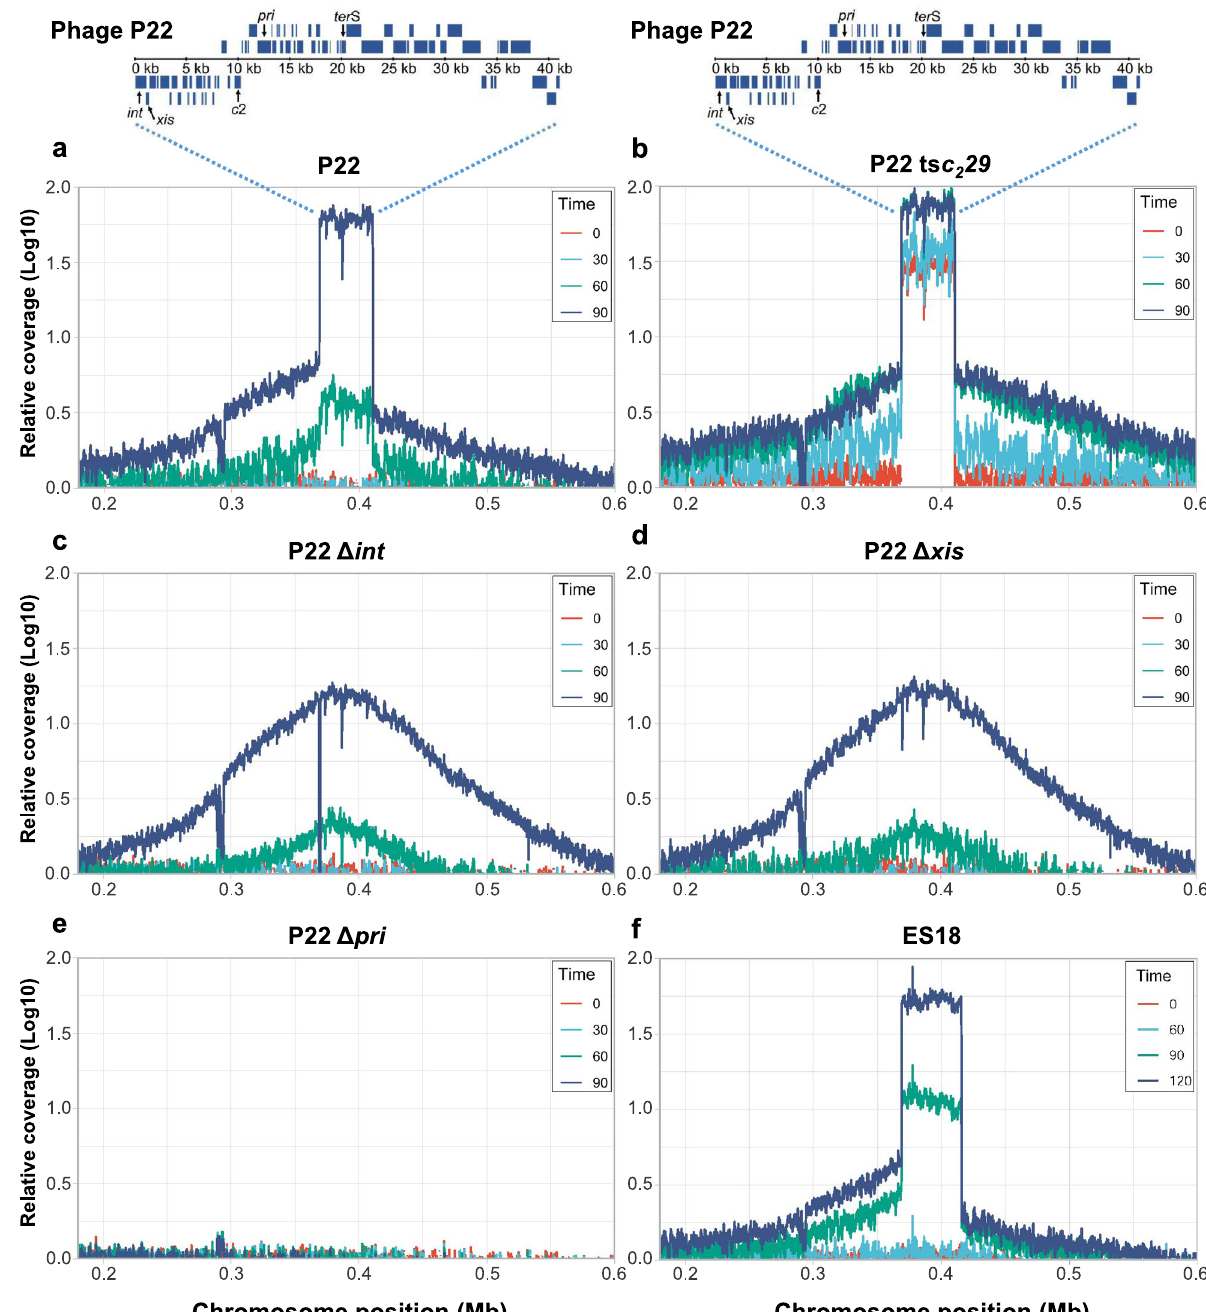
Fig. 3 Phage P22 and ES18 replicate in situ before excision. Relative abundance of phage genomic DNA and the chromosomal regions proximal to where they integrate for P22 ( a ), P22 ts c 2 29 ( b ), P22 Δ int ( c ), P22 Δ xis ( d ), P22 Δ pri ( e ) or ES18 ( f ) is represented. Samples were analyzed at 0 (red), 30 (cyan), 60 (green), and 90 min (blue) after induction of P22 prophage or at 0 (red), 60 (cyan), 90 (green), and 120 min (blue) after induction of ES18 (using mitomycin C or temperature-shift, as appropriate). Relative coverage is the DNA relative to the average bacterial genomic coverage (excluding